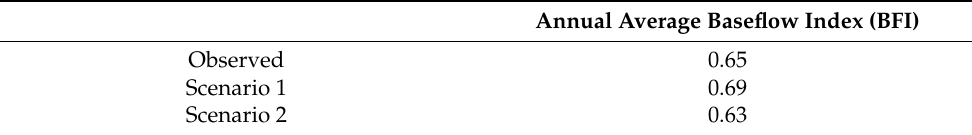
Table 9. A result of baseflow separation (BFI) using BFLOW